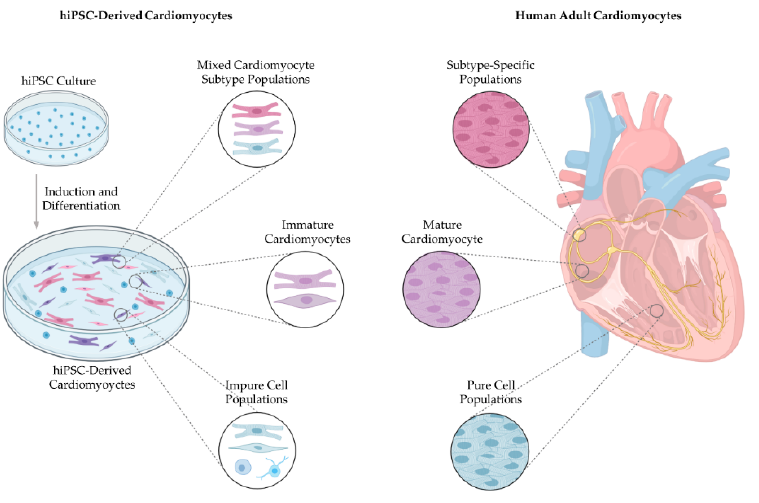
Figure 1. Bioengineered cardiac tissue compared to native adult cardiac tissue. Current hiPSC cardiomyocyte differentiation protocols yield mixed cardiomyocyte subtype populations with immature structure and function, and cell cultures are contaminated with non-cardiomyocytes and undifferentiated cells. Developing a hiPSC-derived cardiomyocyte differentiation process driving subtype-specific, mature and pure cell cultures will be instrumental in extending the clinical application of hiPSC-derived cardiomyocytes. hiPSCs, human-induced pluripotent stem cells.